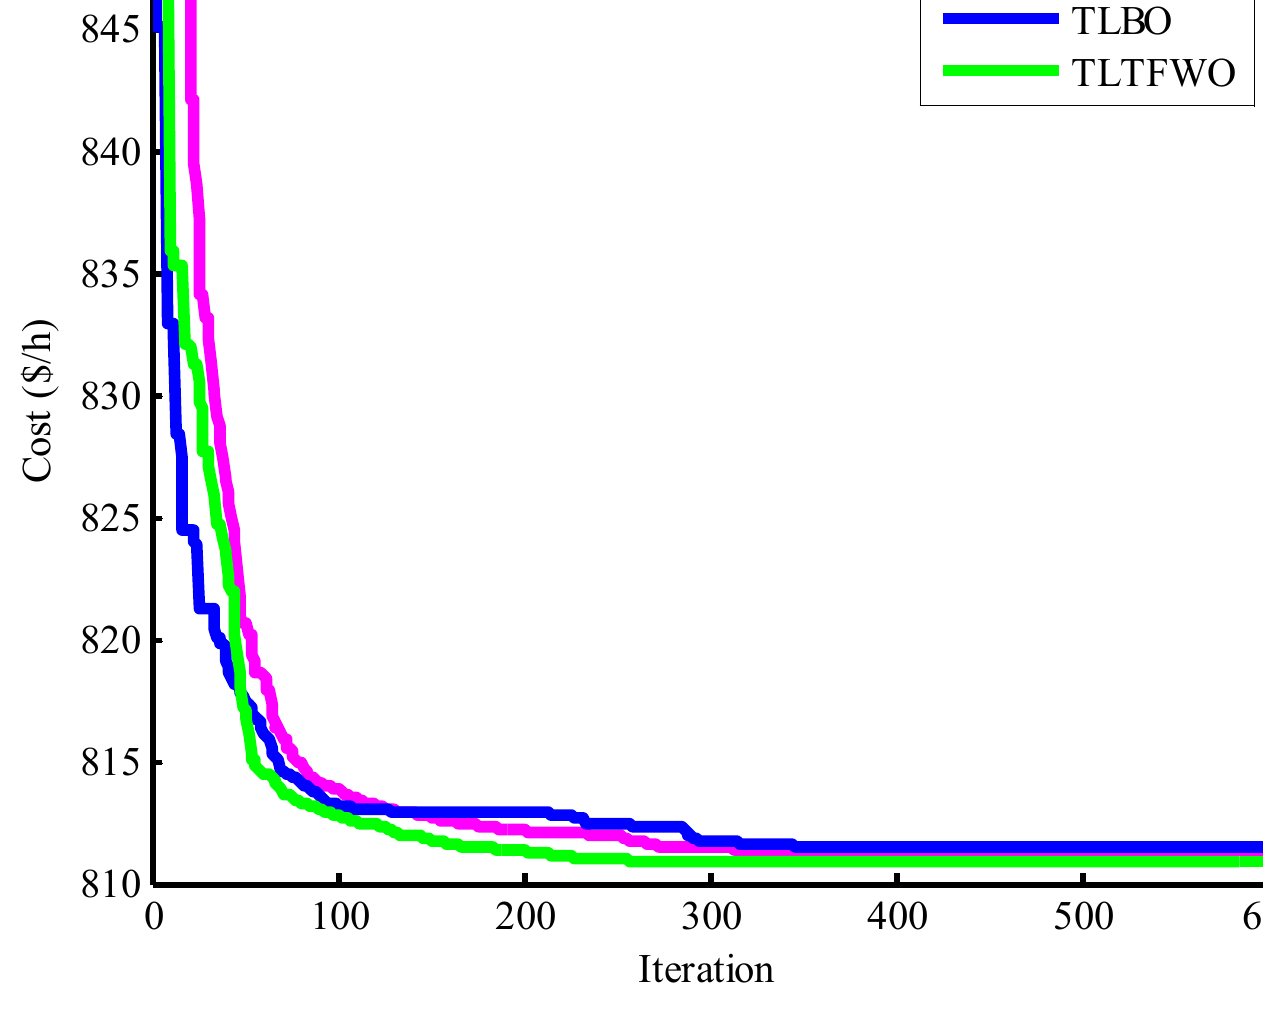
Figure 12. Convergence trends for Case 8.